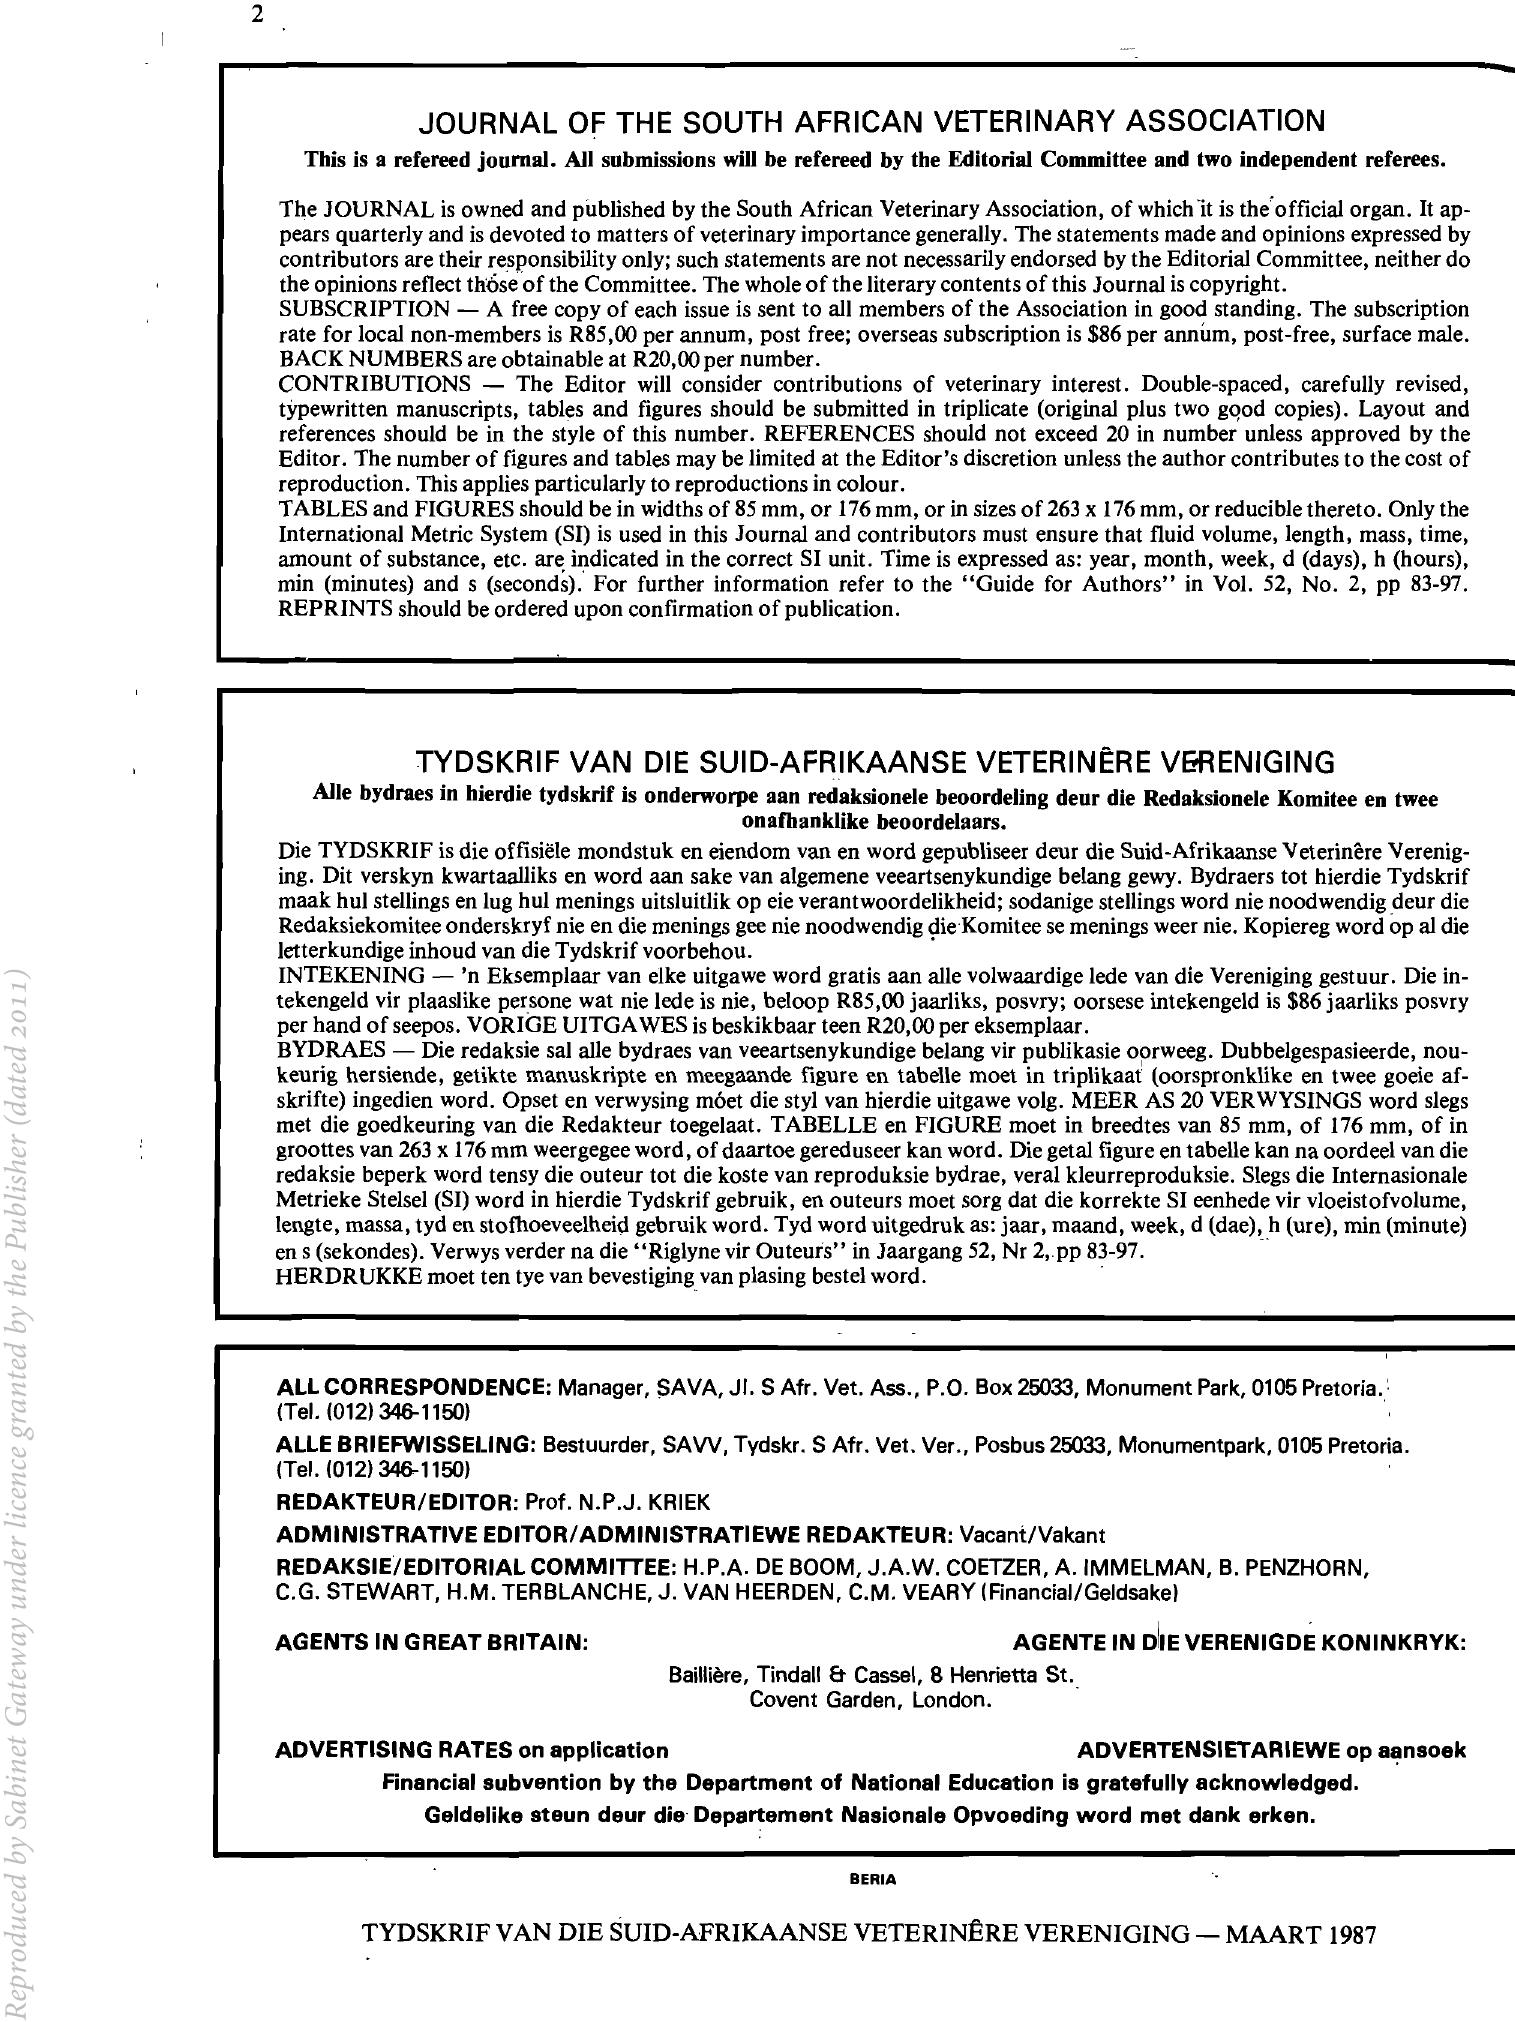
TYDSKRIF VAN DIE SUID-AFRIKAANSE VETERINERE V6flENIGING AIle bydraes in hierdie tydskrif is onderworpe aan redaksionele beoordeling deur die Redaksionele Komitee en twee onafhanklike beoordelaars. Die TYDSKRIF is die offisieIe mondstuk en eiendom van en word gepubliseer deur die Suid-Afrikaanse Veterinere Verenig ing. Dit verskyn kwartaaIliks en word aan sake van algemene veeartsenykundige belang gewy. Bydraers tot hierdie Tydskrif maak hul stelIings en lug hul menings uitsluitIik op eie verantwoordelikheid; sodanige steIlings word nie noodwendig deur die Redaksiekomitee onderskryf nie en die menings gee nie noodwendig die Komitee se menings weer nie. Kopiereg word op al die letterkundige inhoud van die Tydskrif